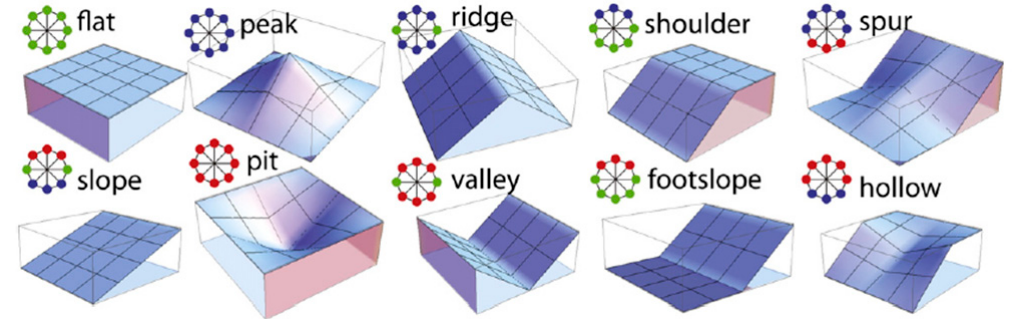
Figure 4. Landform classes in the Geomorphon model [51].